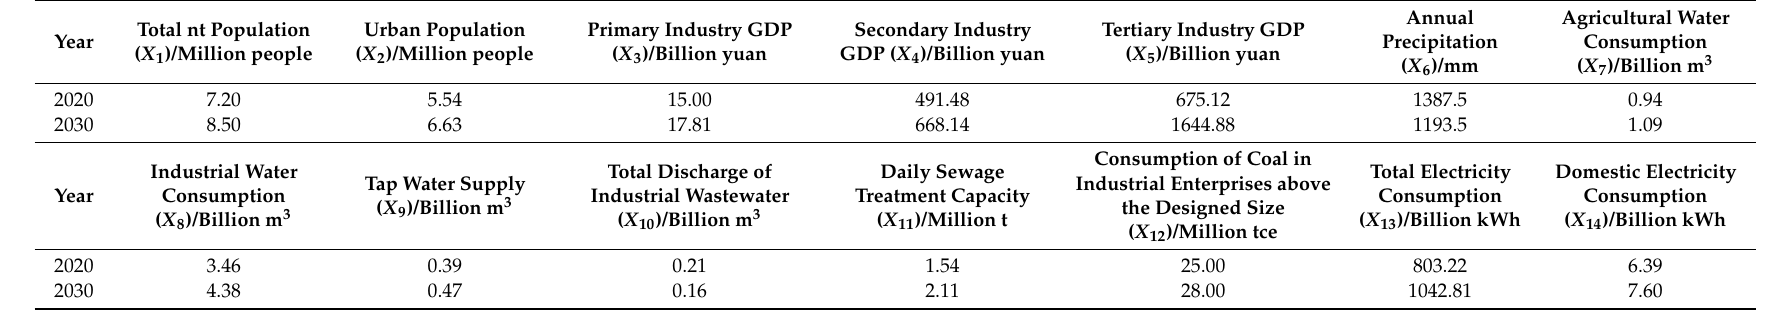
Table 1. Forecasted data of indices for water and energy demand in Wuxi in 2020 and 2030.